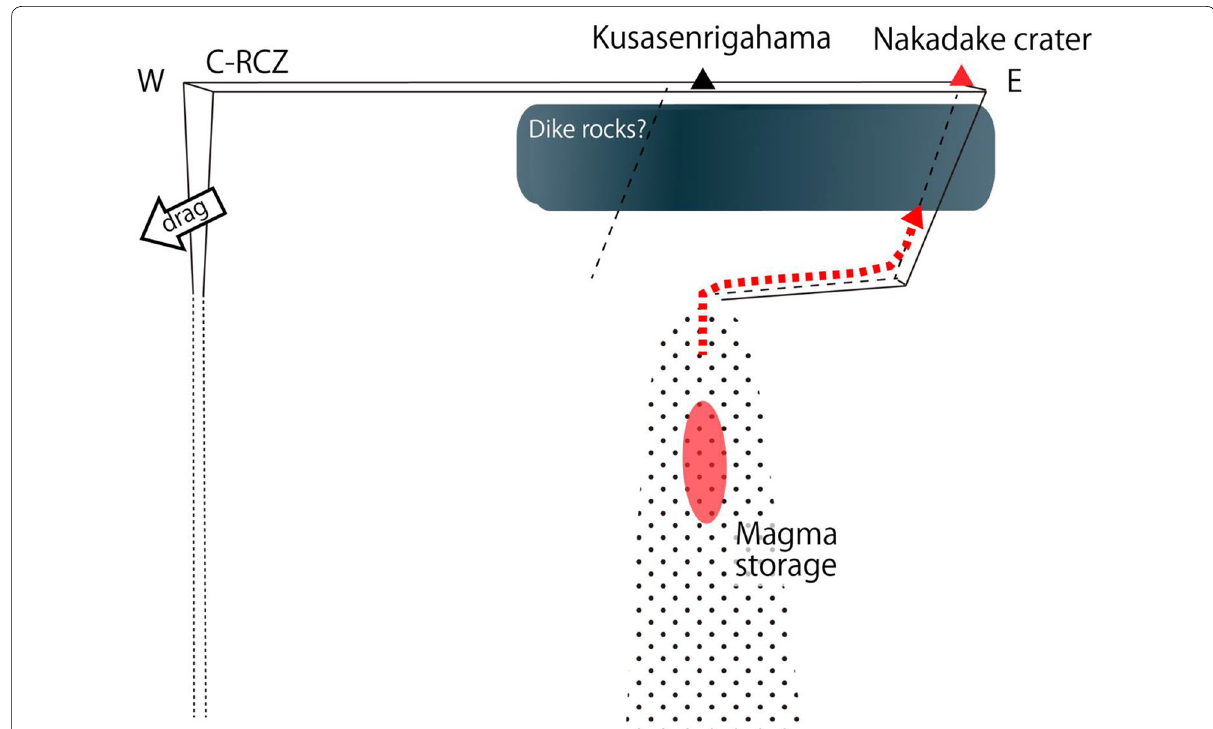
Fig. 12 Schematic magma plumbing system based on